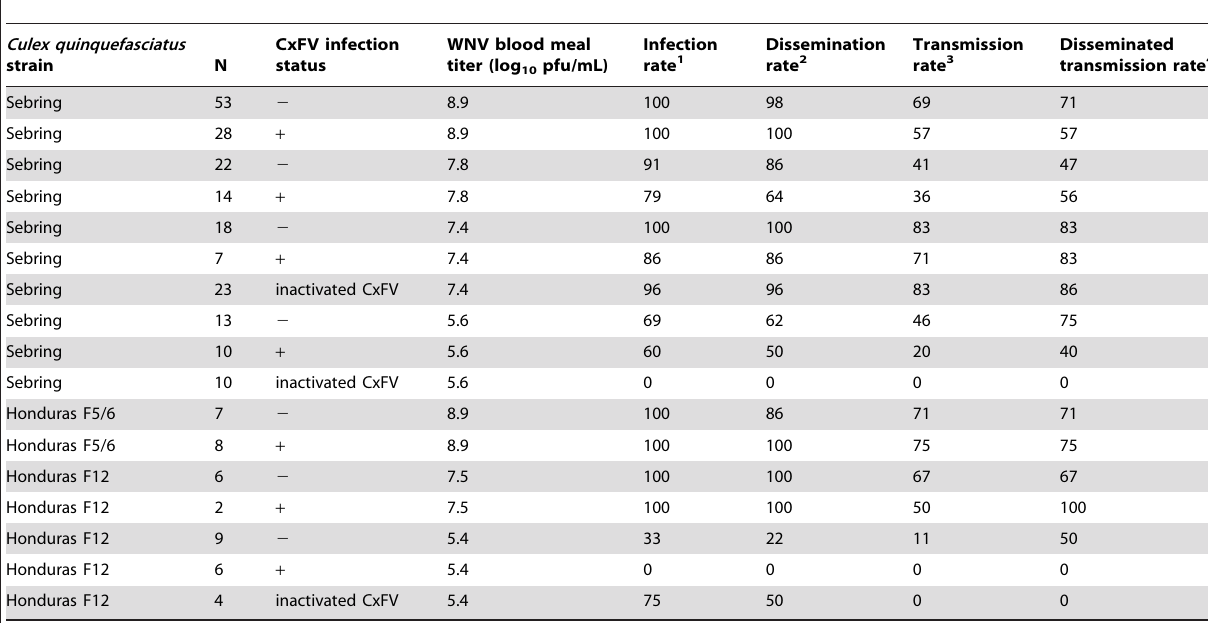
Table 2. WNV Infection, dissemination, and transmission rates in Culex quinquefasciatus either infected sequentially with CxFV Izabal and WNV, or uninfected with CxFV